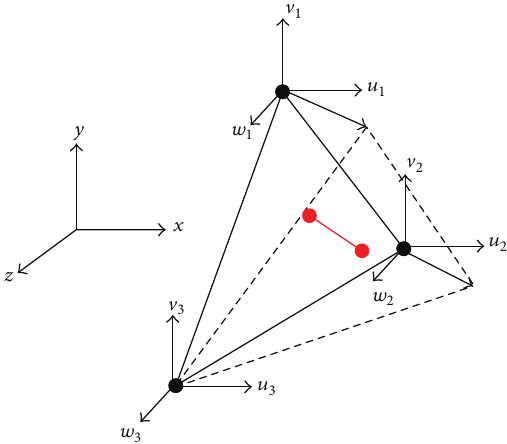
Figure 10: Simplification to triangular element with 3-dimensional DoFs.